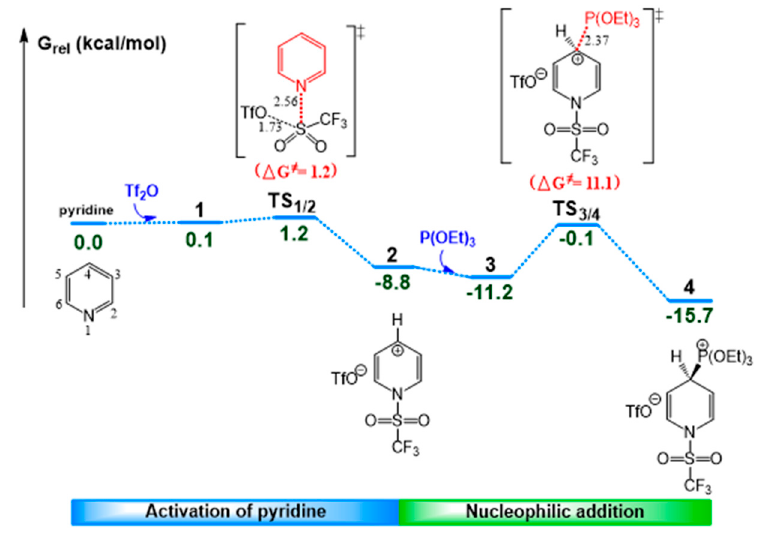
Figure 1. Free energy profile of pyridine activation and nucleophilic addition.